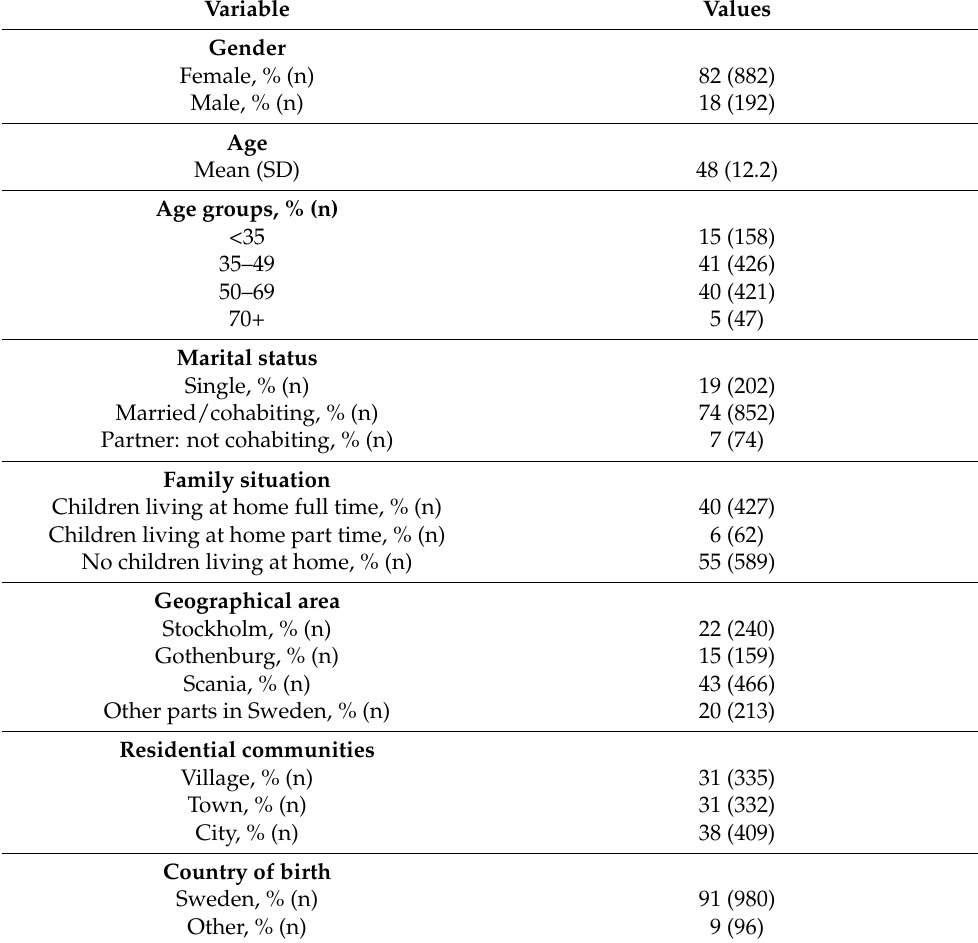
Table 1. Sociodemographic characteristics of the study sample n =